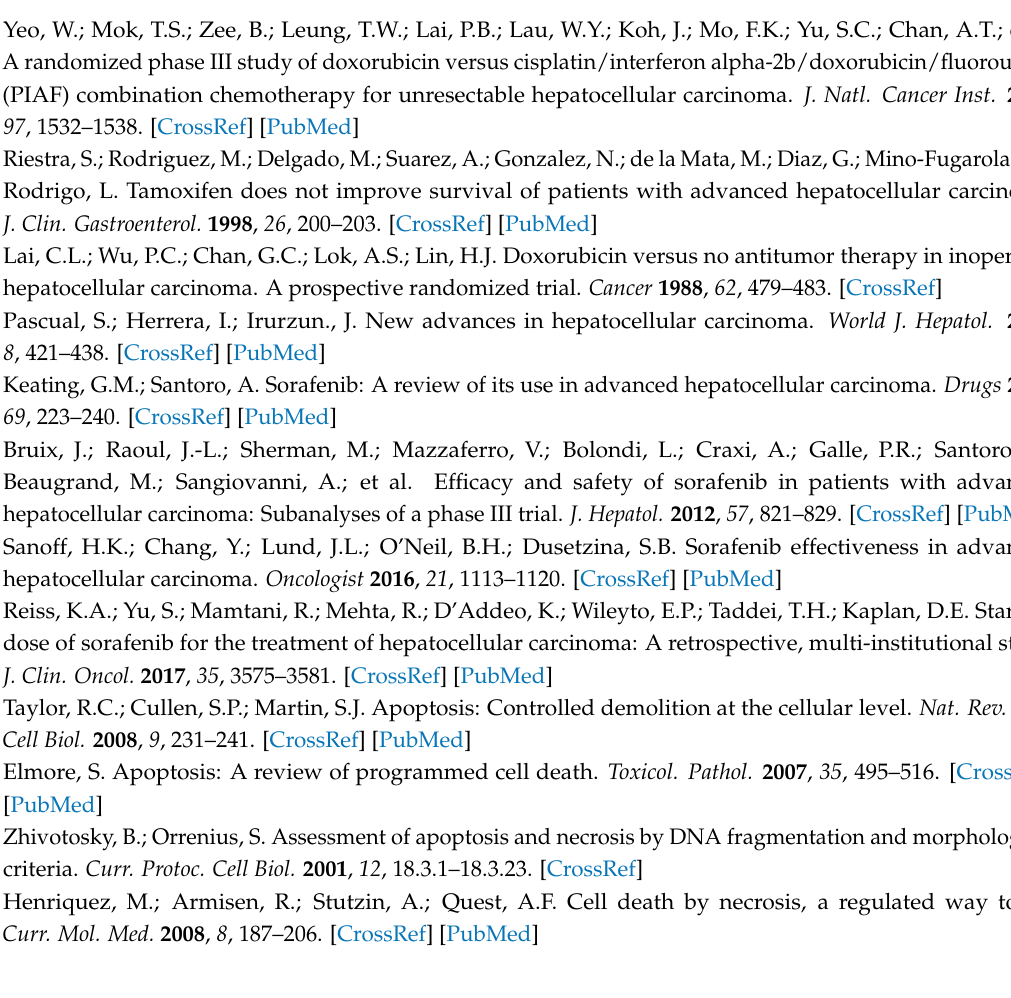
Nuclear Magnetic Resonance (NMR) data of pinnatane A in CDCl 3 . Figure S1: 1 H (600 MHz) NMR spectrum of pinnatane A. Figure S2: 13 C (150 MHz) NMR spectrum of pinnatane A. Figure S3: Distortionless enhancement by polarization transfer-135 (DEPT-135) spectrum of pinnatane A. Figure S4: Homonuclear correlation spectroscopy (COSY) spectrum of pinnatane A. Figure S5: Heteronuclear multiple bond correlation (HMBC) spectrum of pinnatane A. Figure S6: Selected COSY and HMBC correlations of pinnatane A. Figure S7: Infrared (IR) spectrum of pinnatane A. Figure S8: Liquid chromatography–mass spectrometry (LC-MS) spectrum of pinnatane